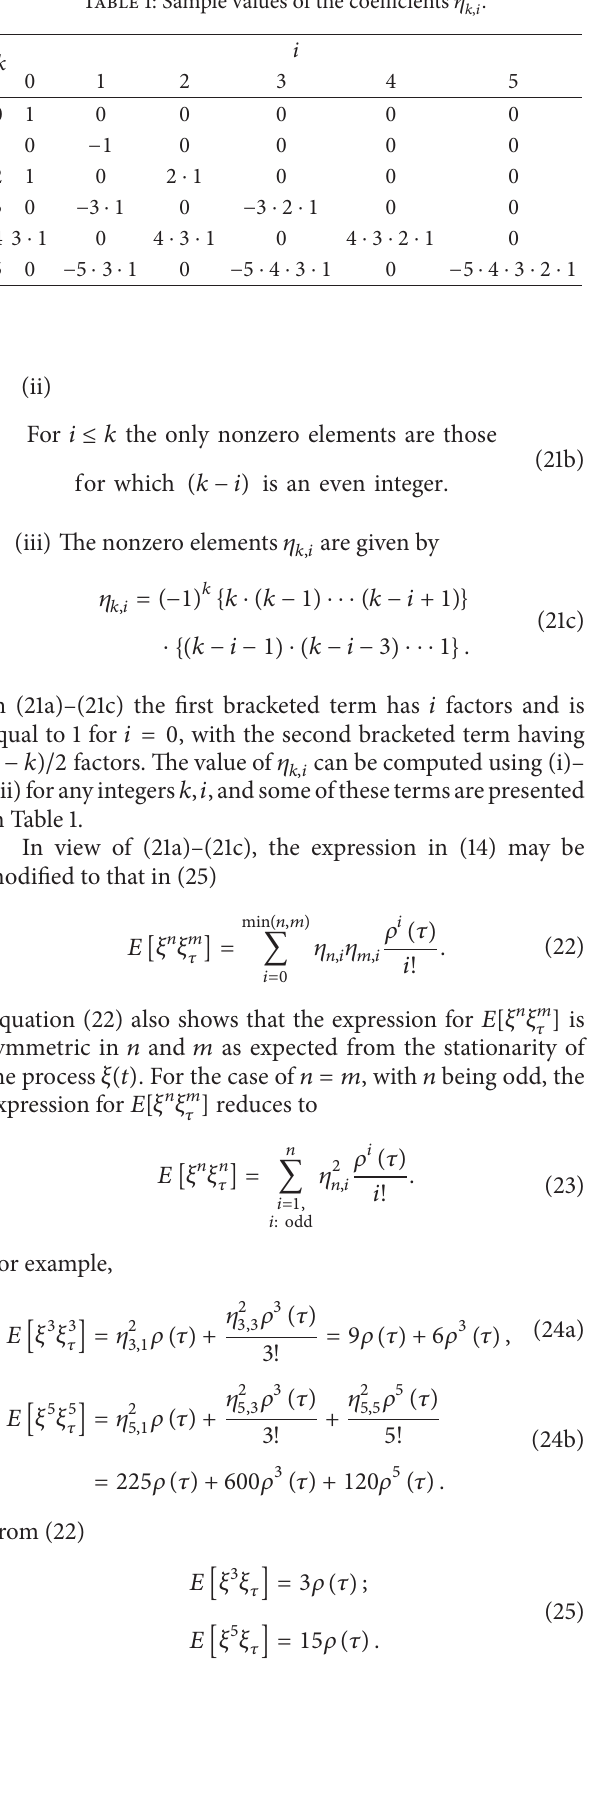
Table 1: Sample values of the coefficients 𝜂 𝑘,𝑖